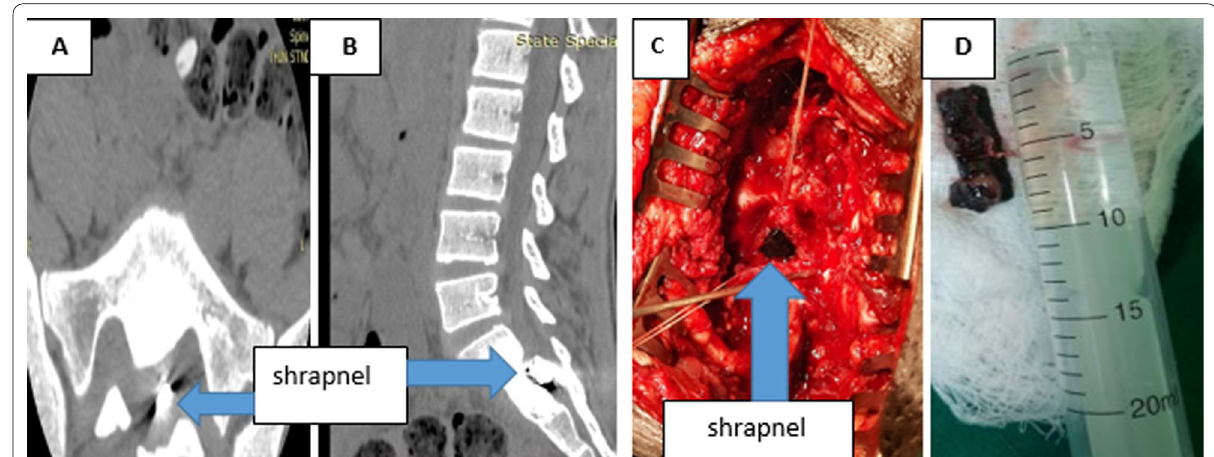
Fig. 2 showing CT Scan findings of S2 canal metallic fragment in axial ( a ) and sagittal reconstructions ( b ), the intraoperative finding of dark colour shrapnel ( c ), the removed shrapnel ( d